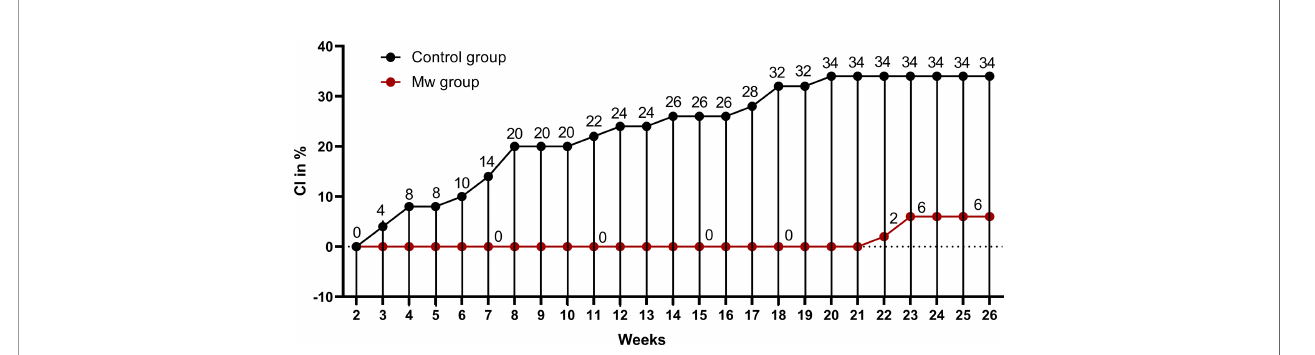
FIGURE 1 | Impact of Mw vaccination on COVID-19 compared to a control group: Points and connecting line plot show the infection trend in Mw group (n=50) and the control group (n=50). The x -axis shows the time in weeks and y -axis shows the cumulative incidence (CI) in %. Red- and black-shaded circles represent Mw group and control group,